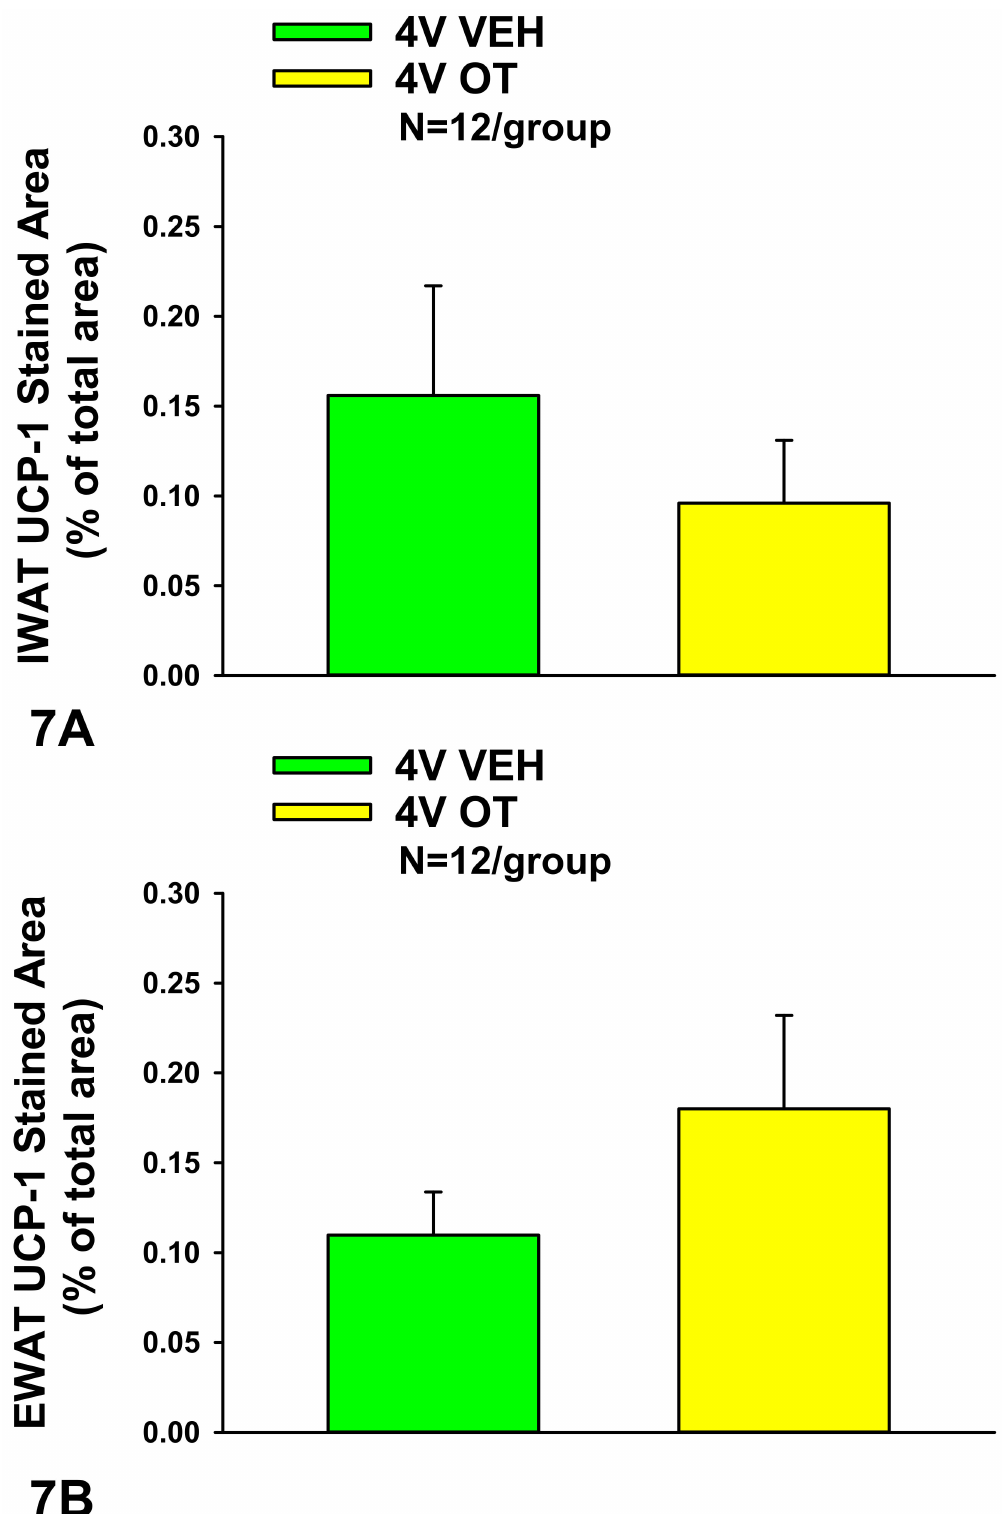
Figure 7. ( A , B ): Effect of chronic 4V OT infusions (16 nmol/day) on UCP-1 content in IWAT and EWAT in male HFD-fed CD ® IGS rats. ( A ), UCP-1 staining was quantified in IWAT from rats that received chronic 4V infusion of OT (16 nmol/day) or vehicle (N = 12/group). ( B ), UCP-1 staining was quantified in EWAT from rats that received chronic 4V infusion of OT (16 nmol/day) or vehicle (N = 12/group). Data are expressed as mean ±